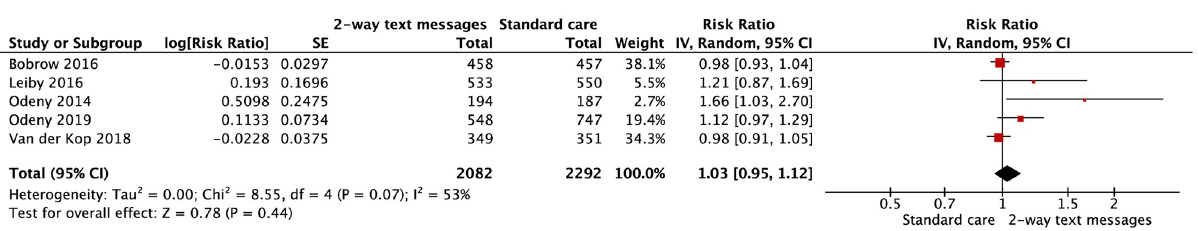
Fig 4. Effect of two-way text messages versus standard care on appointment attendance.